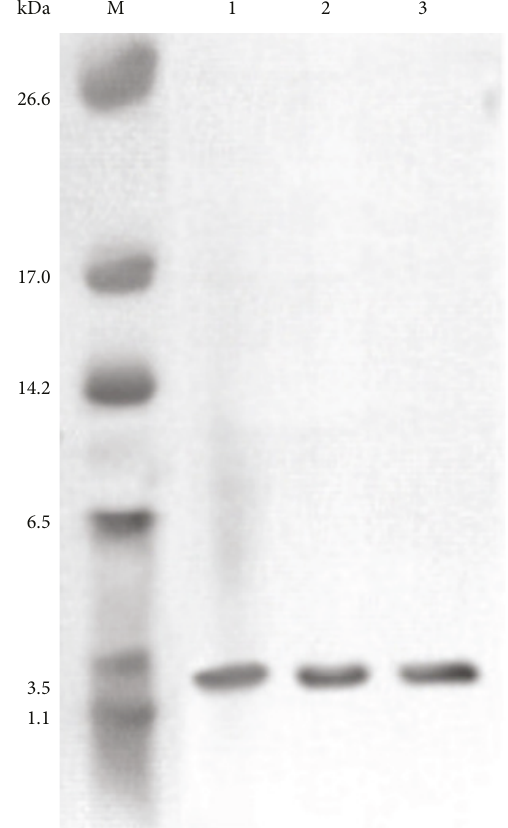
Figure 4: Analysis of Alphastatin integrity by